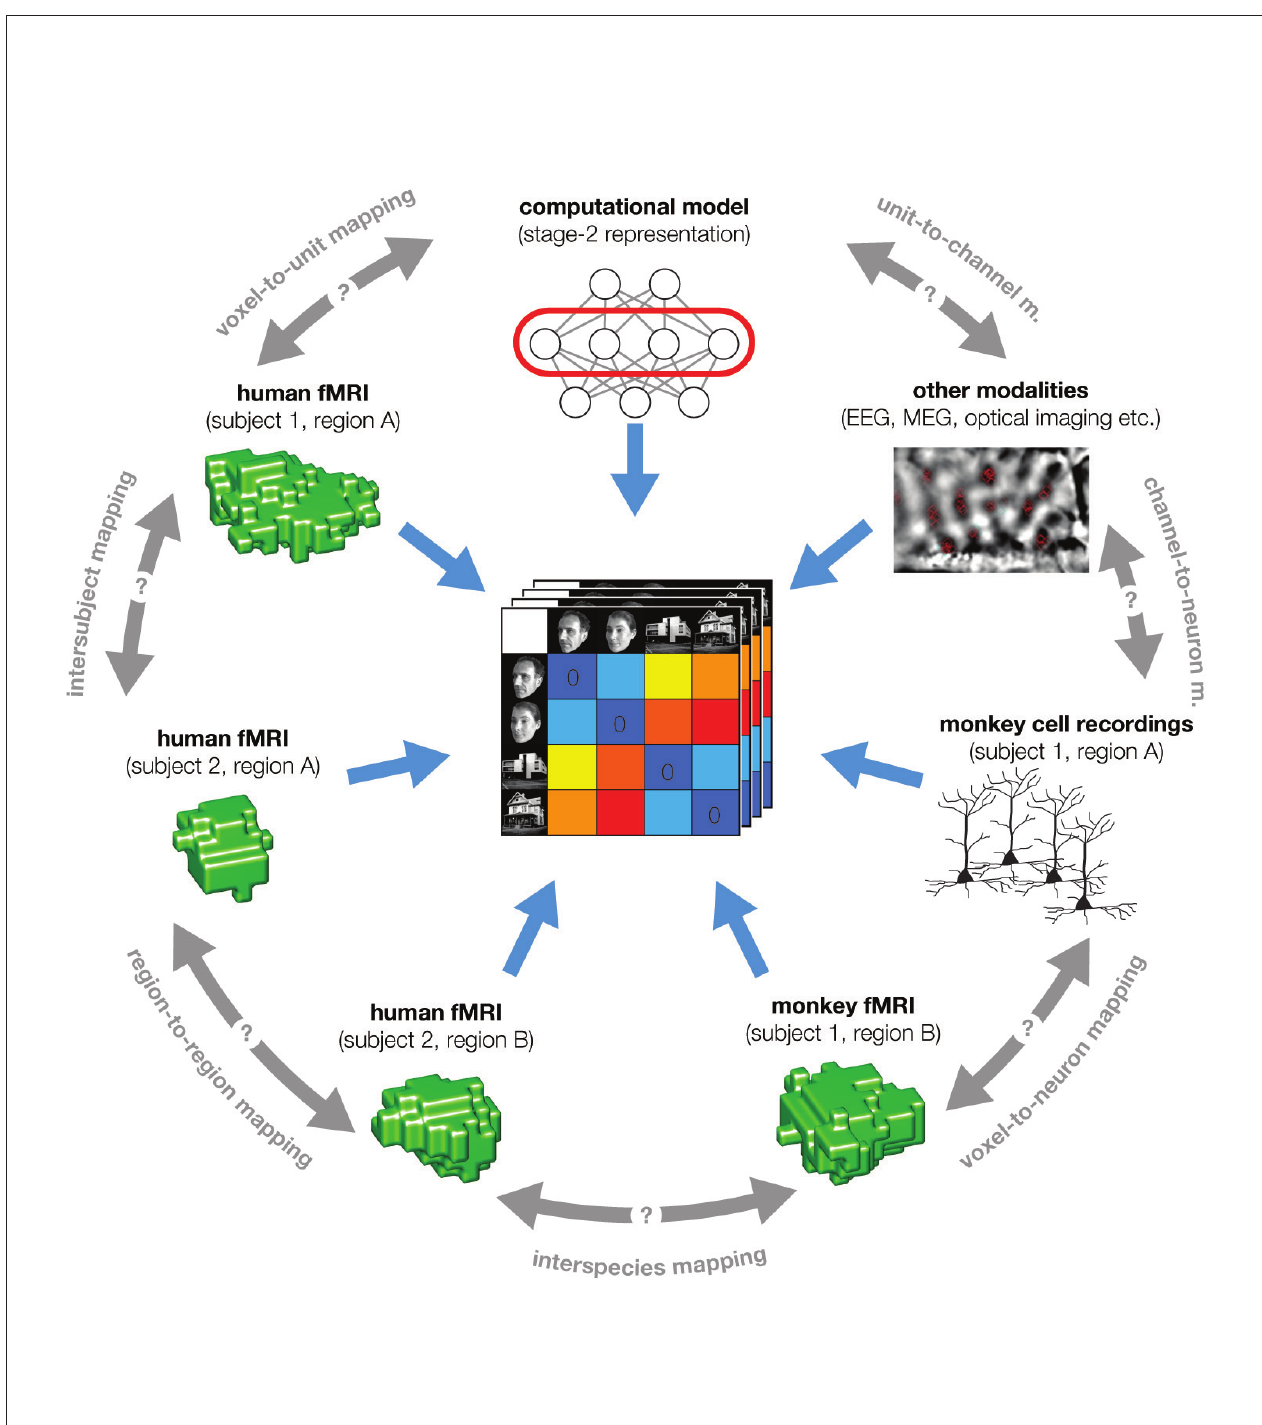
Figure 5 | The representational dissimilarity matrix as a hub that relates different representations. A number of representational relationships (gray text along the perimeter) can be established via the representational signature provided by the RDM. In particular, we arbitrarily chose the example of fMRI to illustrate the relationships that can be established within a single modality of brain-activity measurement: subject-to-subject, region-to-region, and